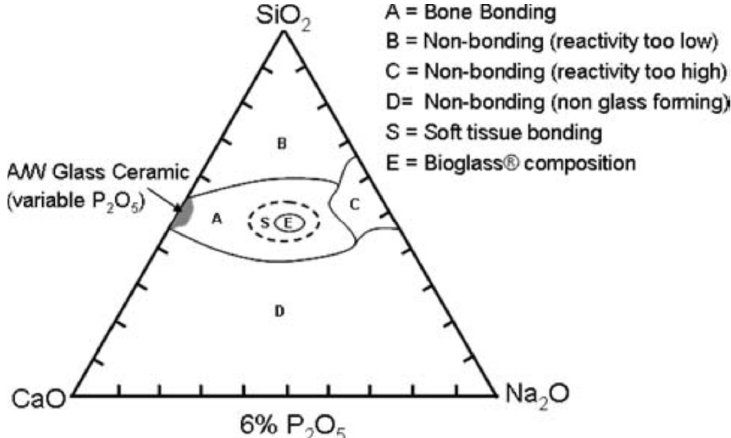
Figure 2. Compositional diagram used to design silicate bioactive glasses. Reproduced from [37] Hench, L.L. The story of bioglass. J Mater Sci Mater Med 2006 , 17 , 967–978. Copyright 2006 Springer Nature.